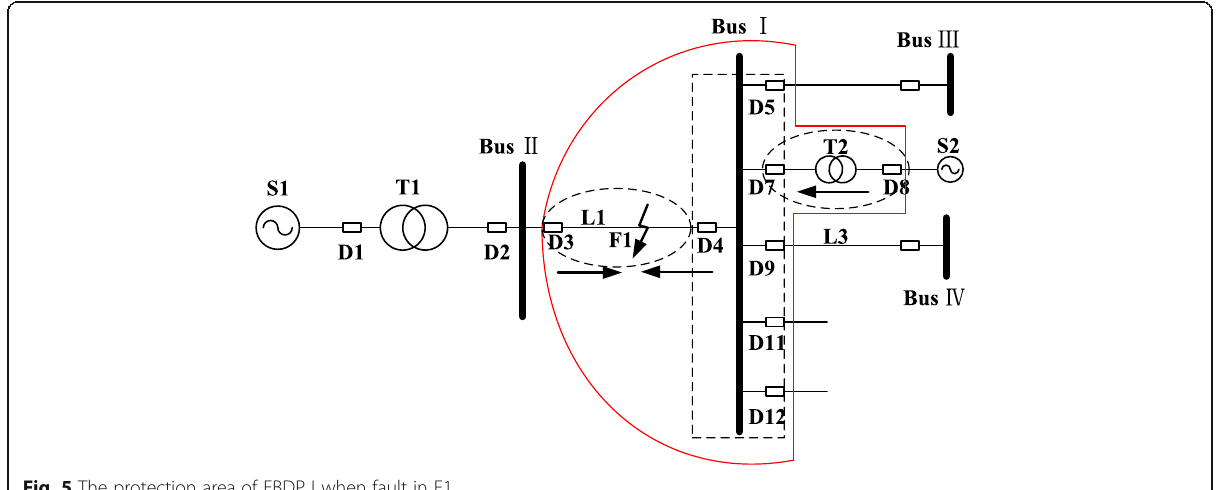
Fig. 5 The protection area of EBDP I when fault in F1